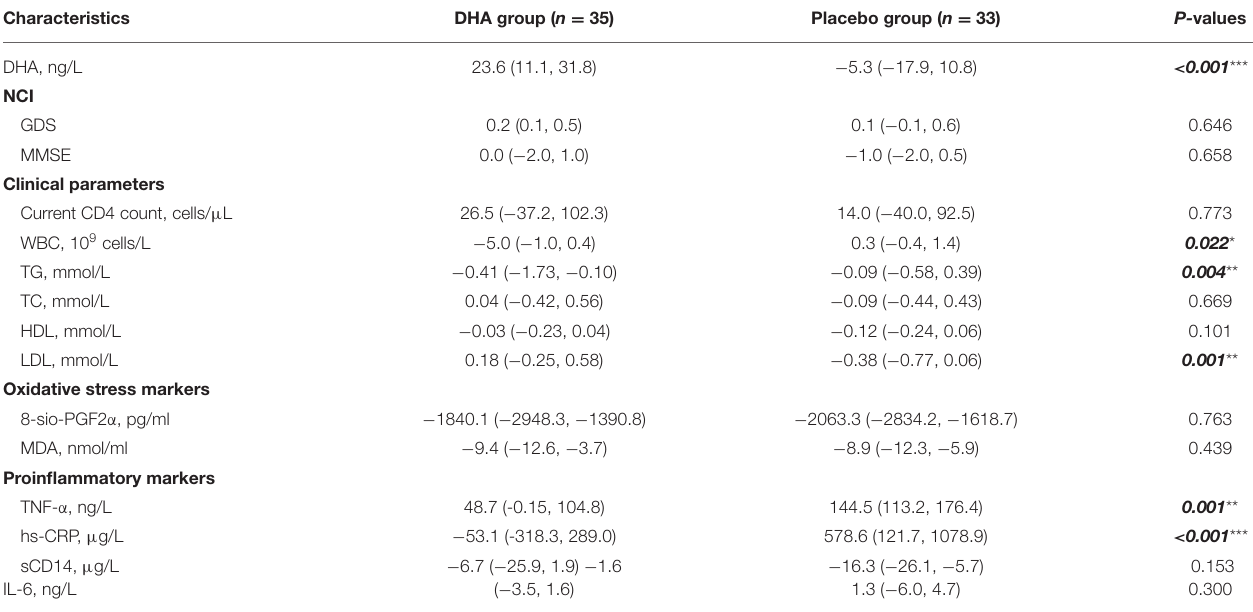
TABLE 2 | Effects of DHA supplement on concerned parameters ( n = 68). Characteristics